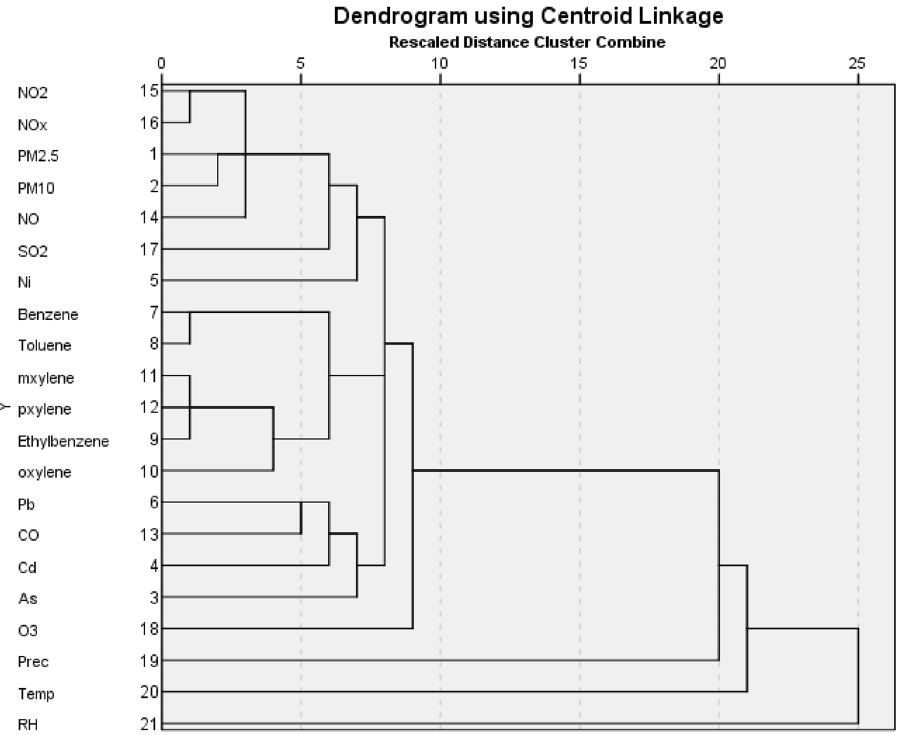
Figure 5. Hierarchical cluster analysis of the studied air pollutants.